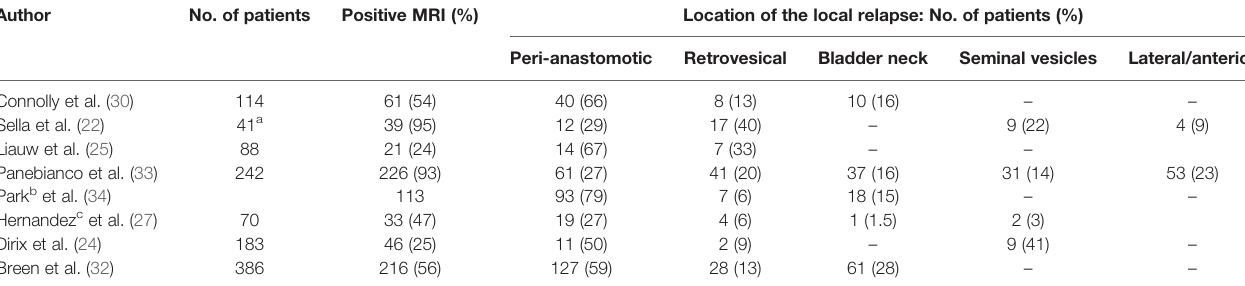
TABLE 1 | Locations by MRI of local recurrences after radical prostatectomy.